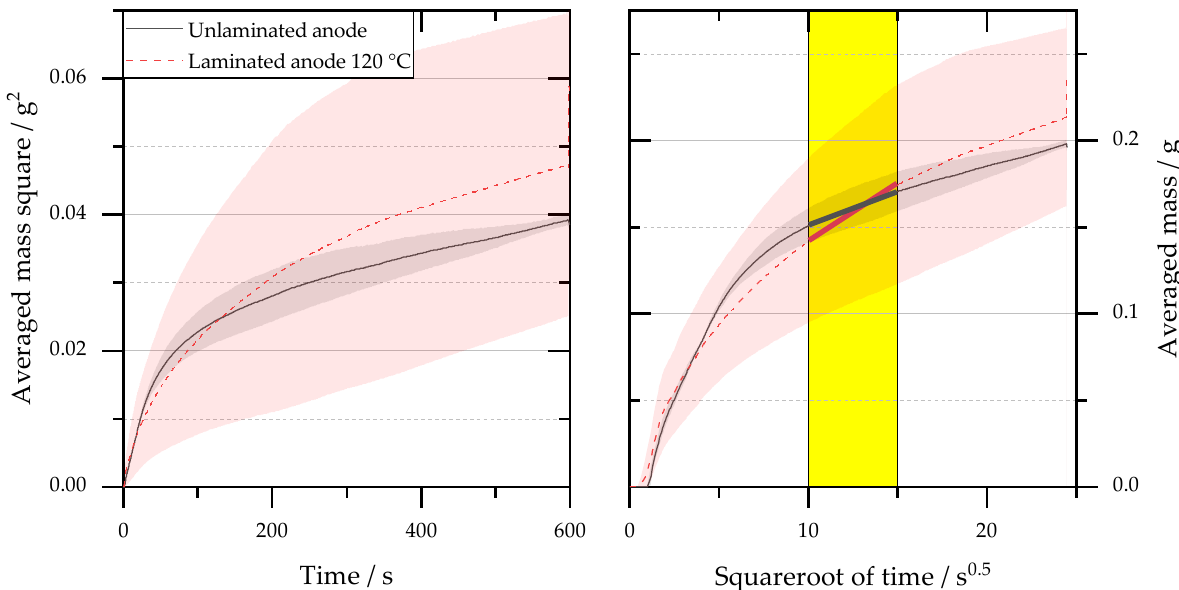
Figure A1. Results of gravimetric measurement of the anode separator measurement series (iv) to (v). Smoothed measurement data of the tensiometer measurement ( left ) and transformed measurement data with an evaluation range of 10 to 15 s 0.5 ( right ).